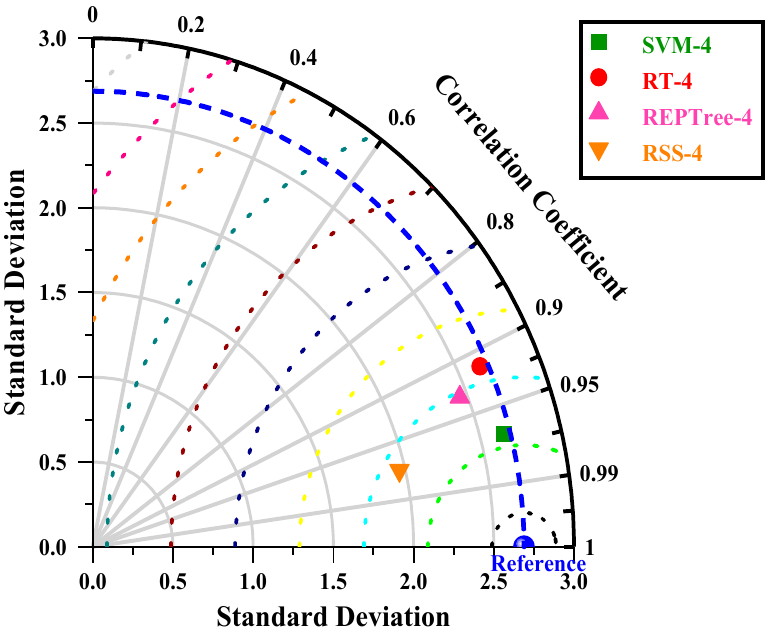
Figure 11. Taylor diagrams of SVM-4, RT-4, REPTrees-4, and RSS-4 during testing.